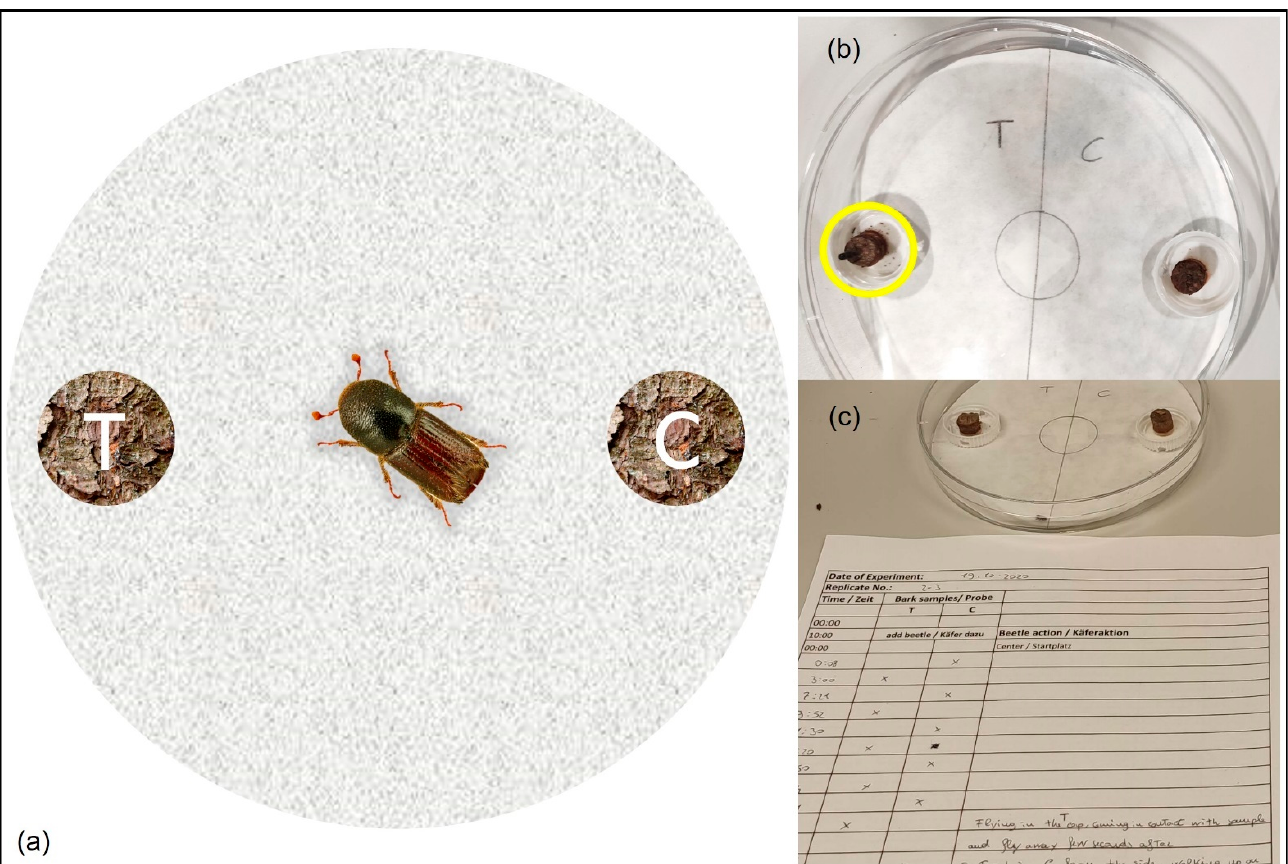
Figure 2. ( a ) Setup of a Petri dish arena choice test, including freshly thawed bark cores of test (roofed trees, R or non-roofed trees, nR) and control (C1 or C2) trees and a freshly emerged Ips typographus (L.) male; ( b ) a beetle made a choice for the T sample; ( c ) recording of beetle activity/behavior over a maximum time span of 60 min.